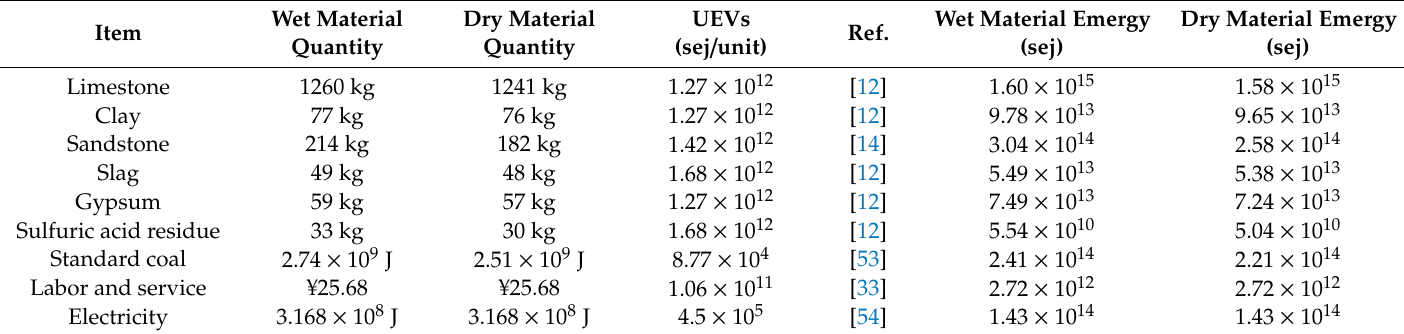
Table 17. Emergy calculation of the cement products based on nonrenewable